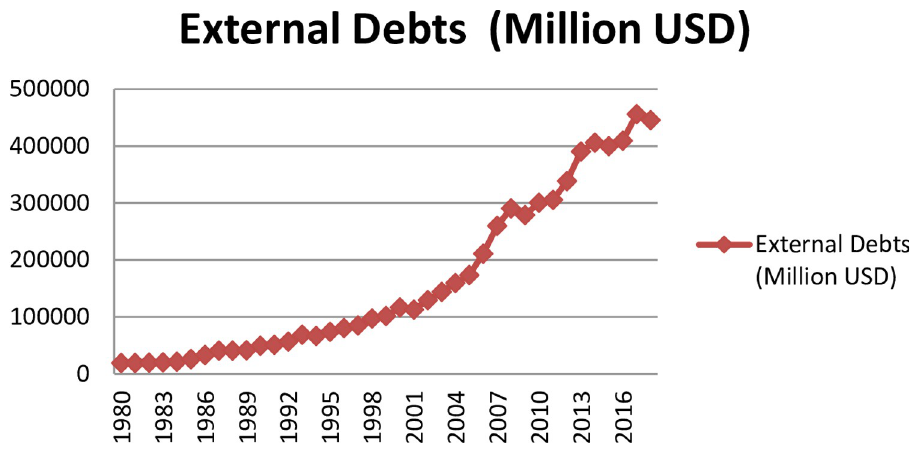
Fig 3. External debt in Turkey for the period from 1980 to 2016 in Turkey. Source: world Bank.